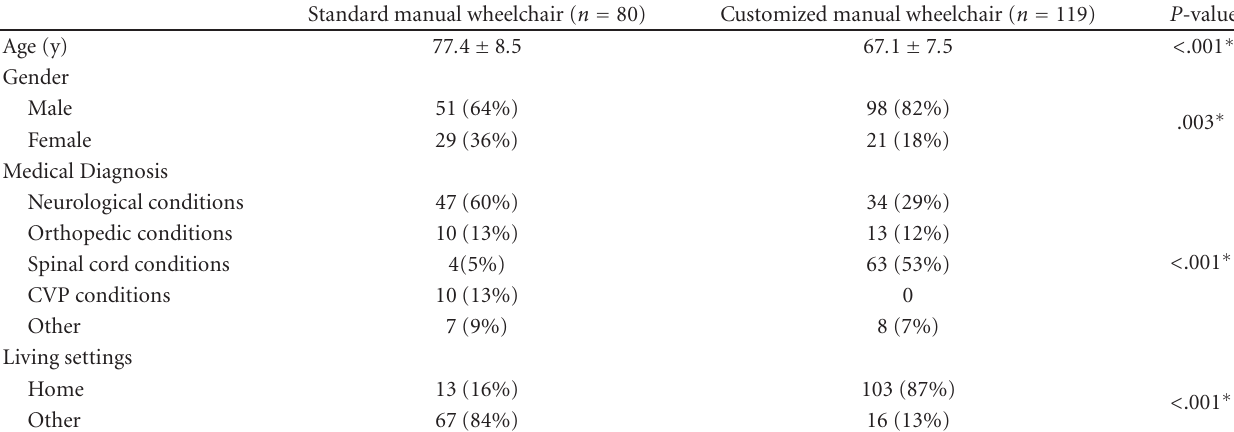
Table 4: Tier 3: Factors associated with use of standard versus customized manual